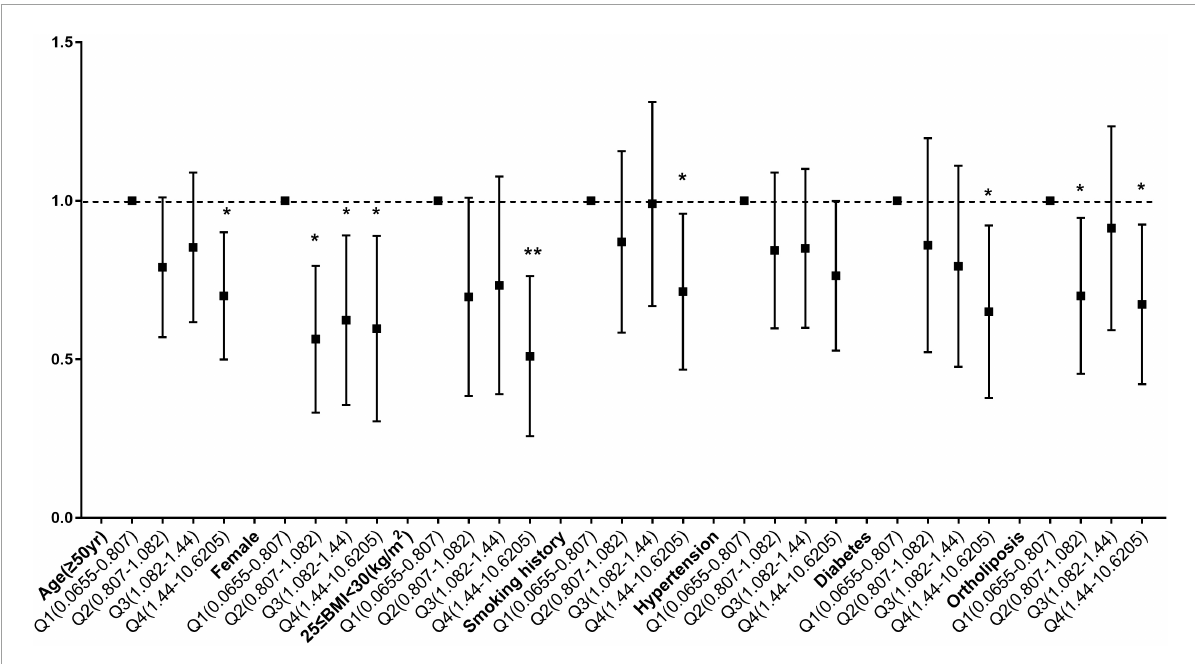
FIGURE5 Subgroup analysis of dose-related copper intake and myocardial infarction after matching. * p < 0.05, ** p <